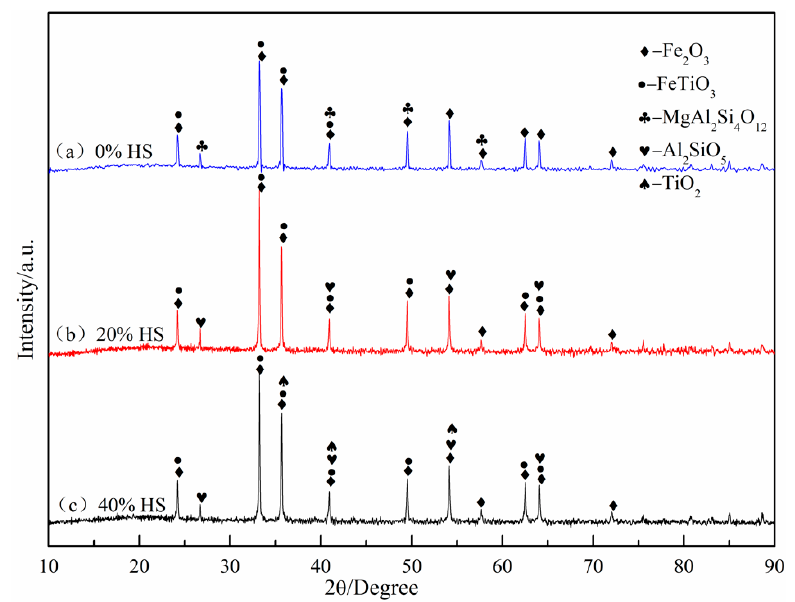
Figure 8. X-ray diffraction analysis of oxidized pellets with different dosages of sea sand ore.